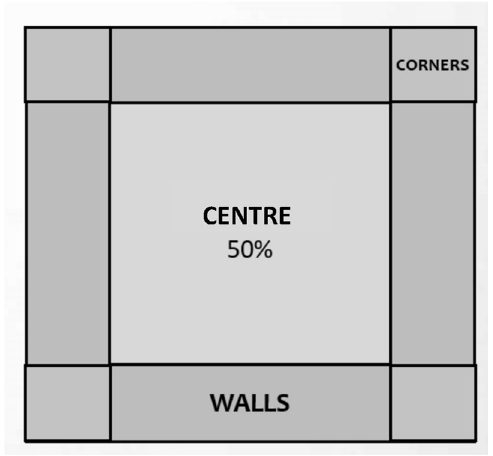
Figure 2. Zones in the Open field test. The centre zone covered 50% of the base of the arena, the rest of the arena was divided into a wall zone and a corner